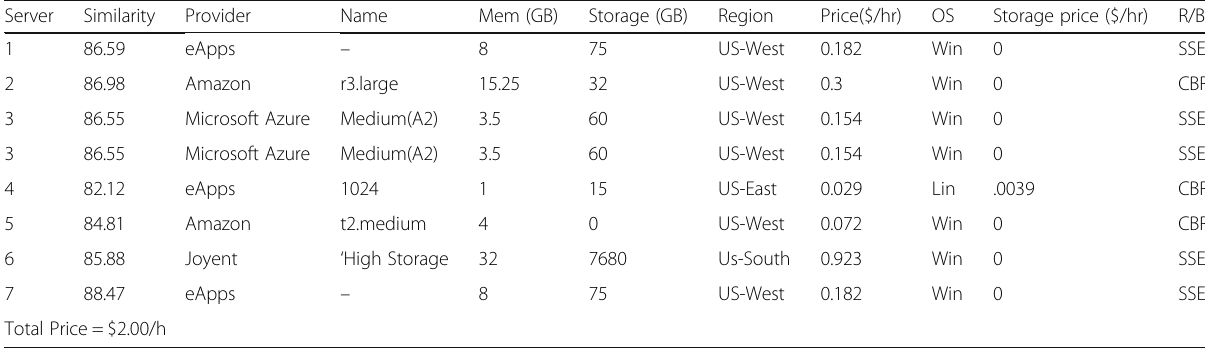
Table 4 Recommended services for each deployment entity